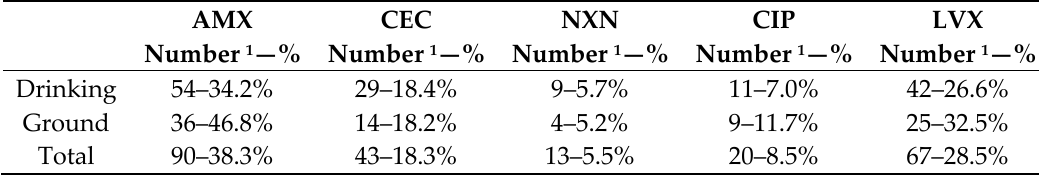
Figure 2. Frequency of resistance of E. coli strains isolated from drinking and ground water to 5 antibiotics. Table 3. Resistance of E. coli strains to 5